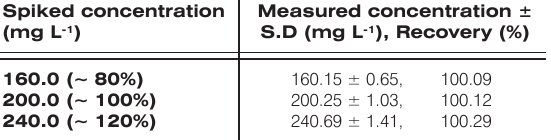
Table 2. Recovery studies (n =